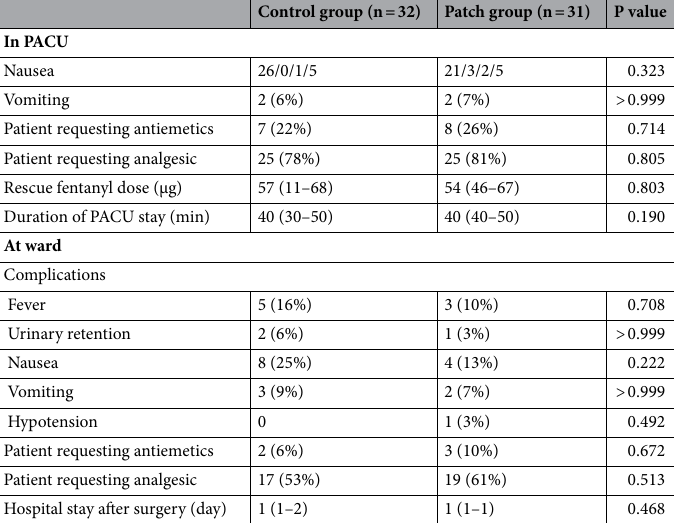
Control group (n = 32) Patch group (n = 31) P